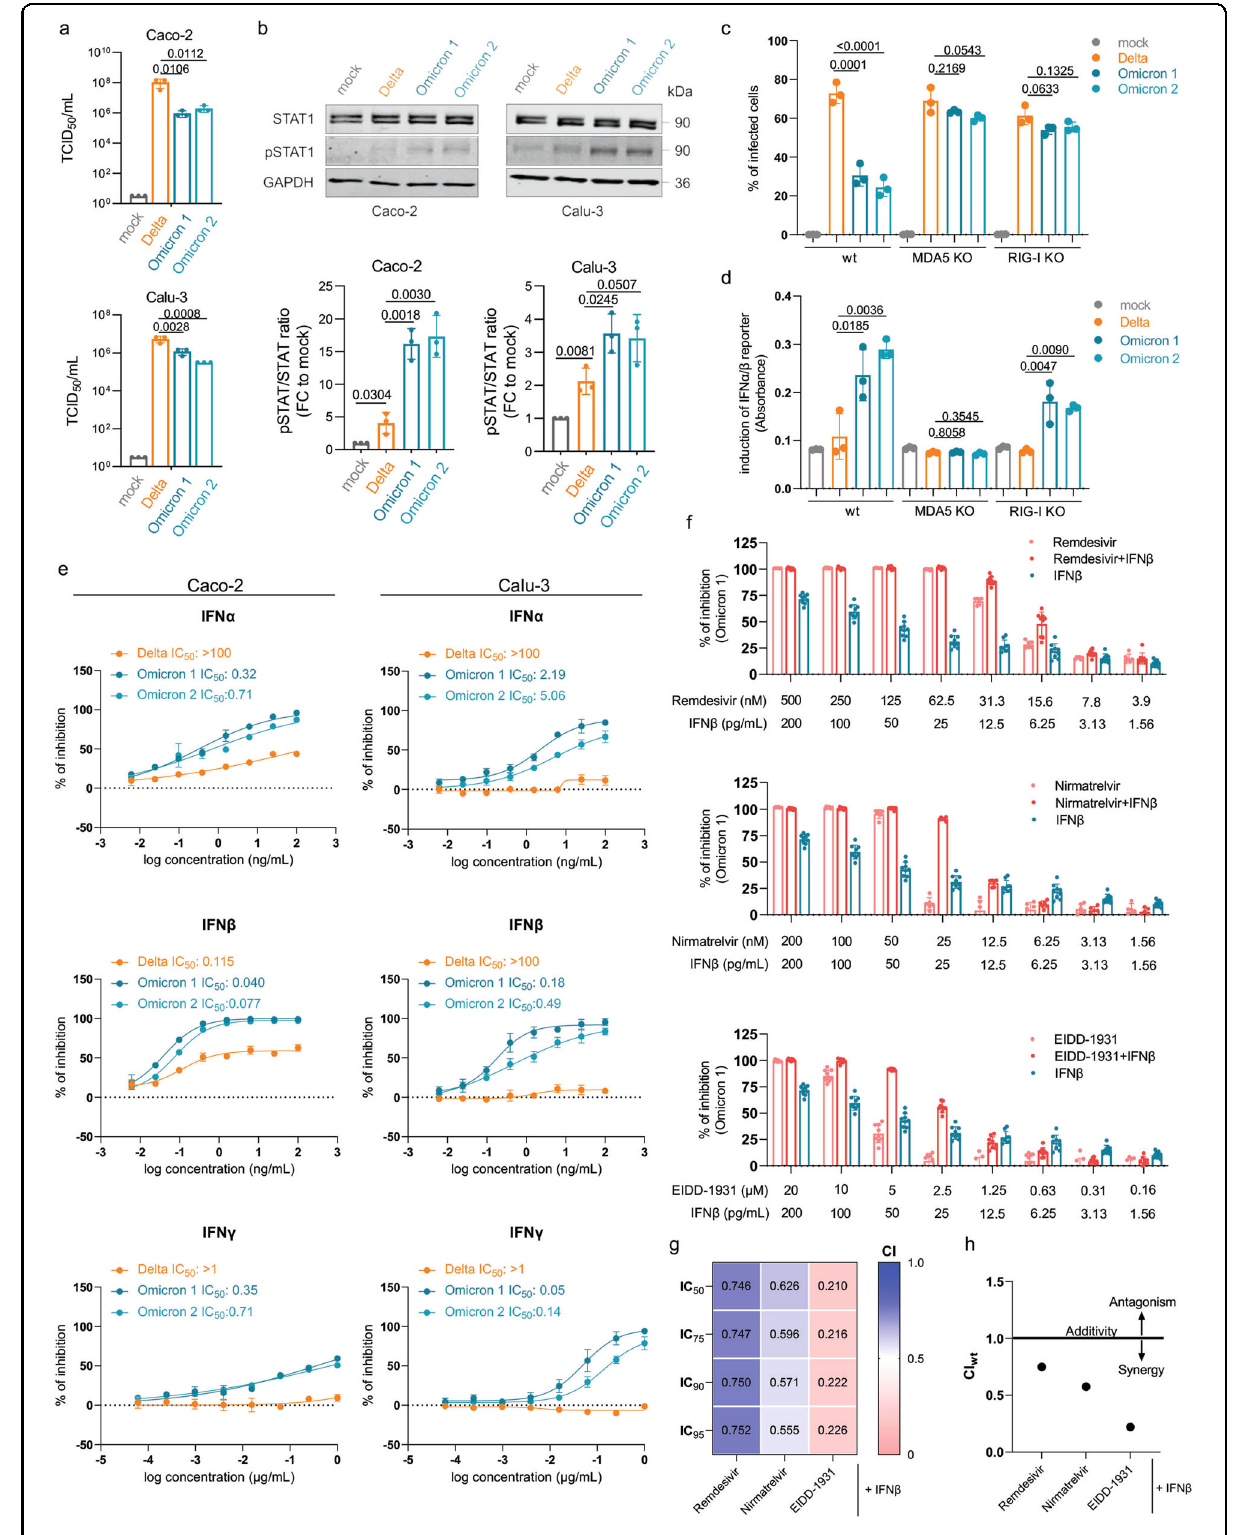
Fig. 1 (See legend on next